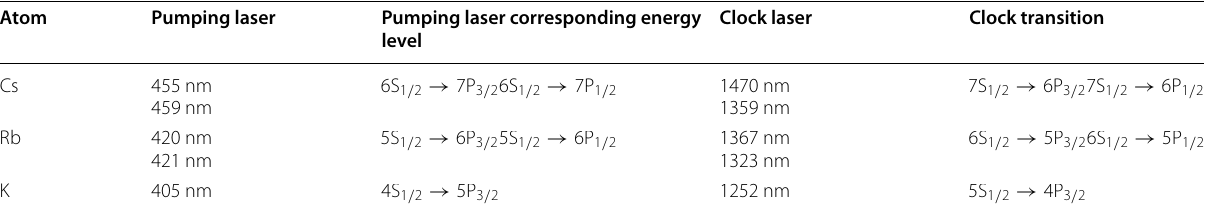
Table 3 A few options for four-level active optical clocks Atom Pumping